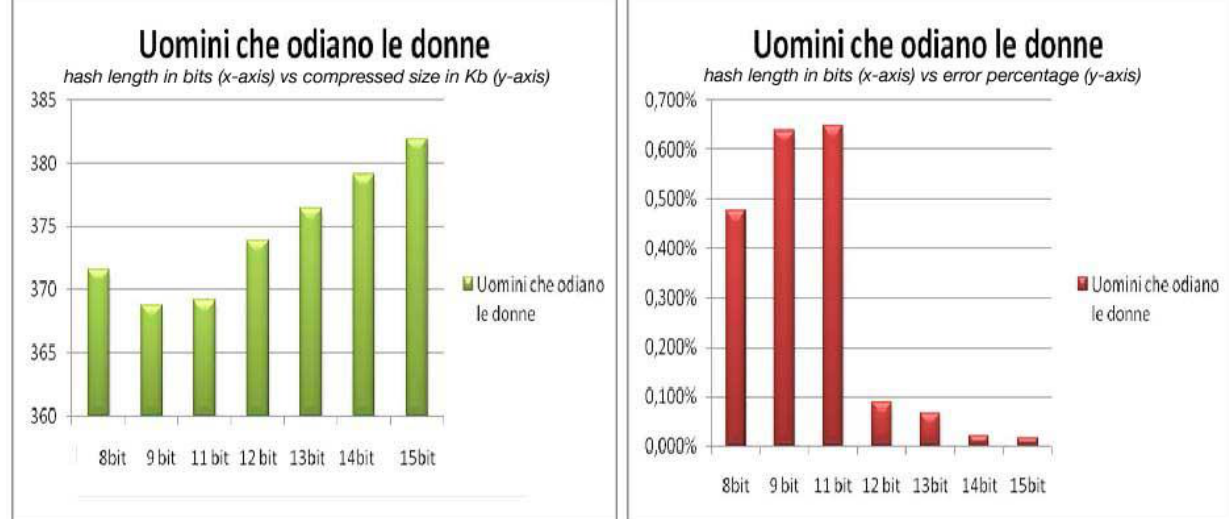
Figure 3. Compression and hash length for “Uomini che odiano le